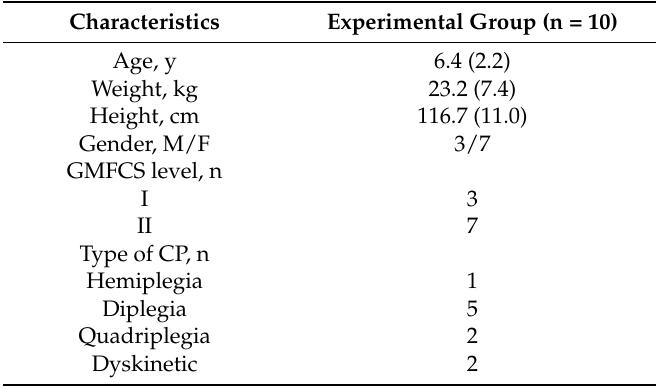
Table 1. Baseline characteristics of the ten participants, values are means